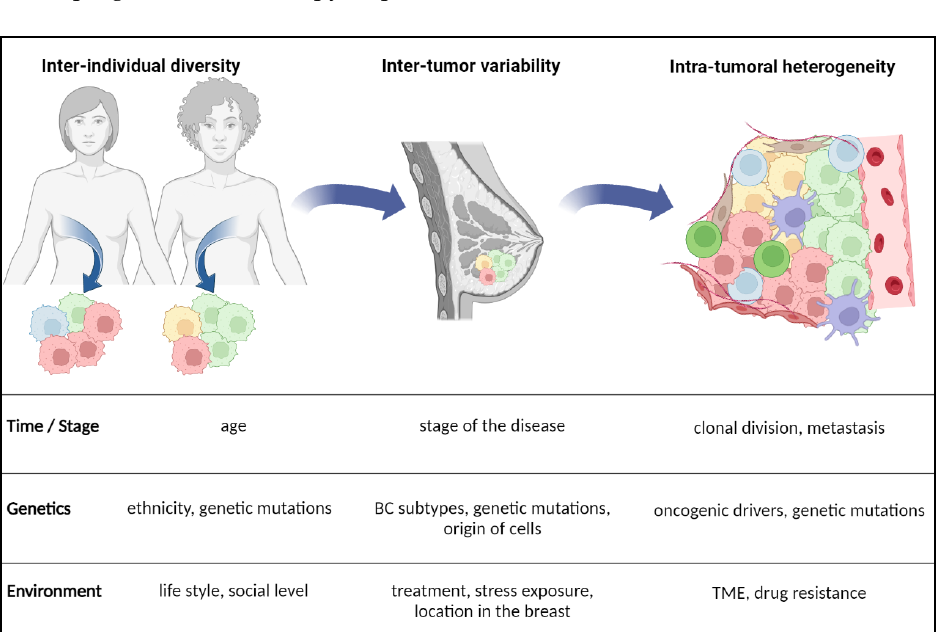
Figure 1. Different scales and factors of heterogeneity in breast cancer. Heterogeneity in breast cancer might be dependent on individuals, the environment and cell types within the tumor microenvironment. For each scale, main factors of heterogeneity (time, genetics and environment) may vary in their impacts and approach. For example, a single genetic mutation can be common to two unrelated women but differentially expressed within their respective tumors.